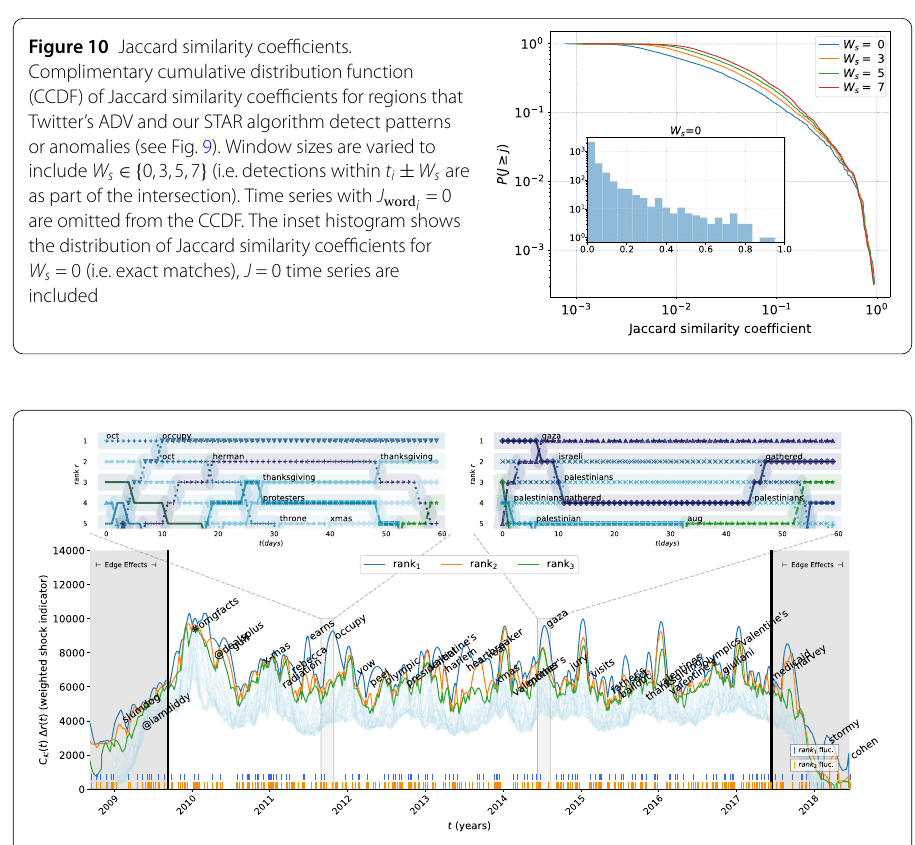
Figure 11 Shock leaderboard. Time series of the ranked and weighted shock indicator function. At each time step t , the weighted spike indicator functions (WSIF) are sorted so that the word with the highest WSIF corresponds to the top time series, the words with the second-highest WSIF corresponds to the second time series, and so on. Vertical ticks along the bottom mark fluctuations in the word occupying ranks 1 and 2 of WSIF values. Top panels present the ranks of WSIF values for words in the top 5 WSIF values in a given time step for the sub-sampled period of 60 days. An interactive version of this graphic is available at the authors’ webpage: